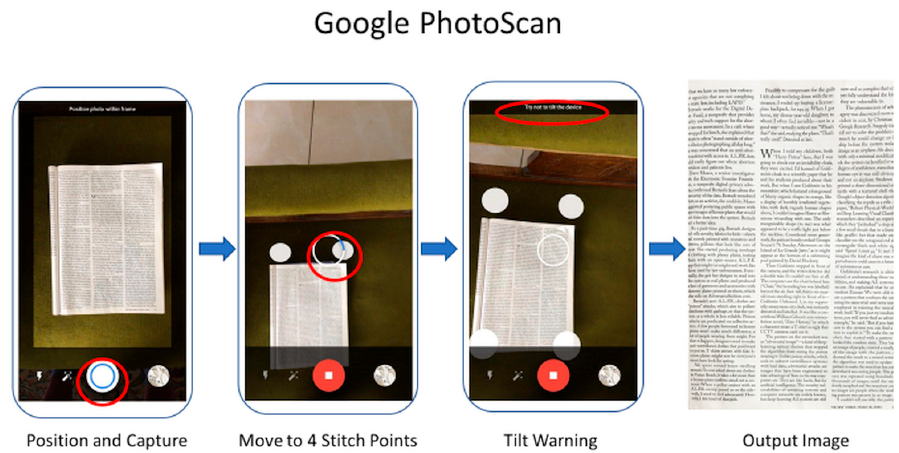
Figure 9. Google PhotoScan UI. An optional manual corner correction phase is also offered and is not shown, although is often necessary as automatic cropping is frequently incorrect.